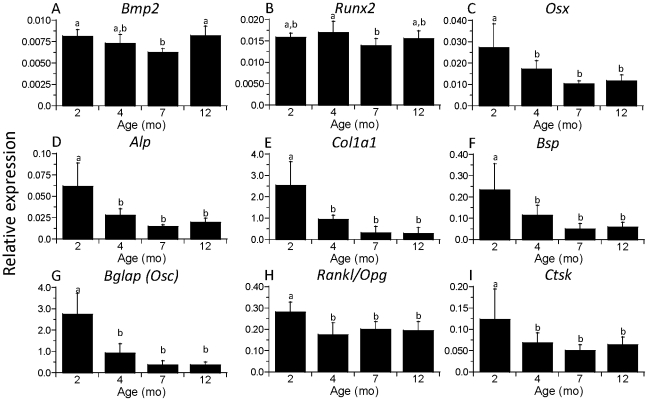
Expression of bone genes is age dependent.mRNA was isolated from the tibia of baseline, non-loaded control mice of four different ages, quantified by real-time RT-PCR and expressed relative to the housekeeping gene cyclophilin. Expression of most osteoblast- and matrix-related genes was age-dependent, with significant declines from 2 to 4 months. Expression of osteoclast-related genes also declined from 2 to 4 months but not thereafter. (n = 7–8; mean ± SD; a,b: groups with no common letters are significantly different, p<0.05).